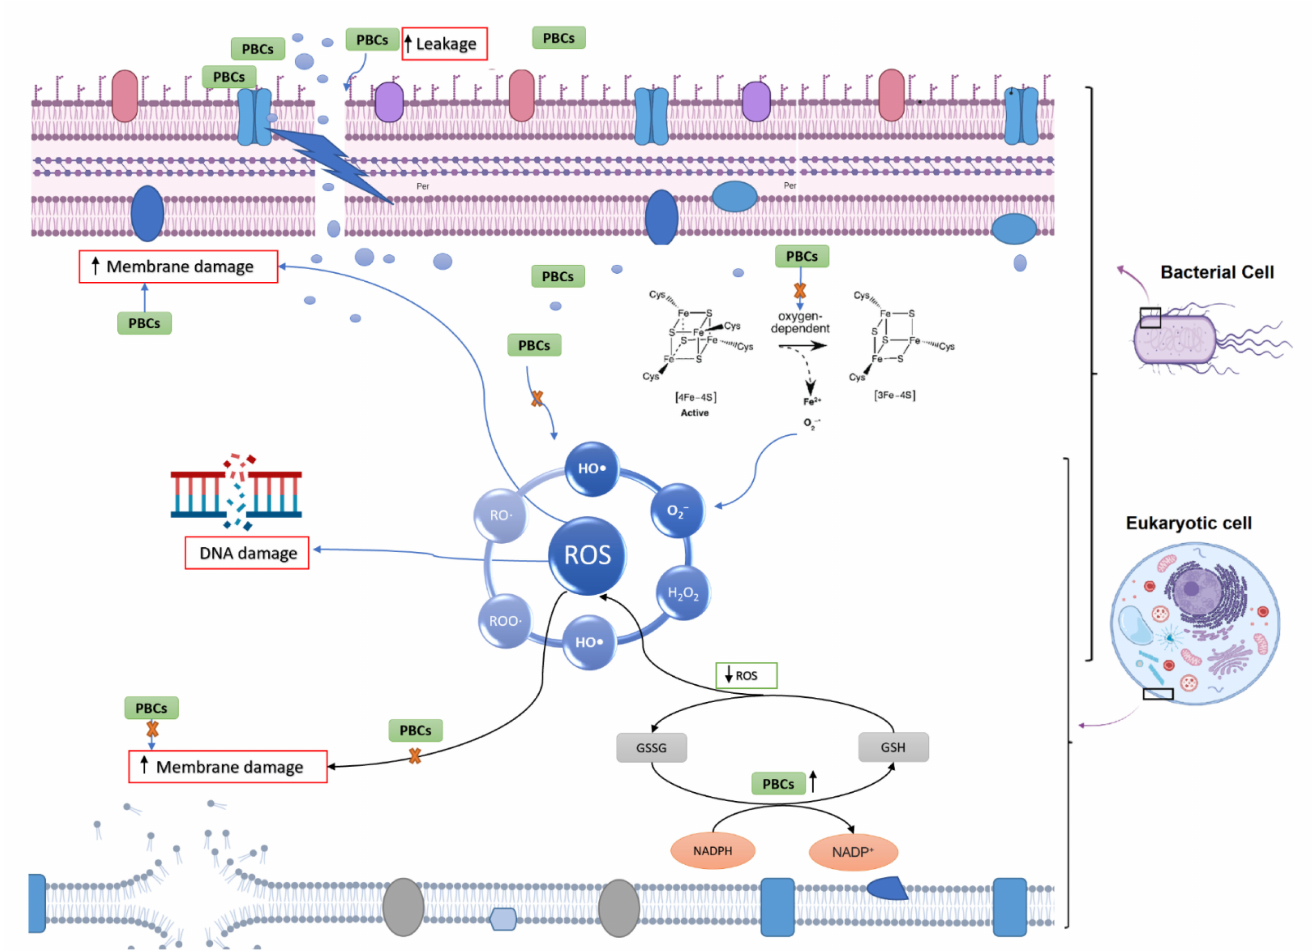
Figure 8. Mechanism illustration of plant-based components (PBCs) in bacterial and eukaryotic cells. Overall, PBCs target the bacterial cell membrane (but not eukaryotic cells) because of their different membrane structure. GSH = glutathione; GSSG = oxidized